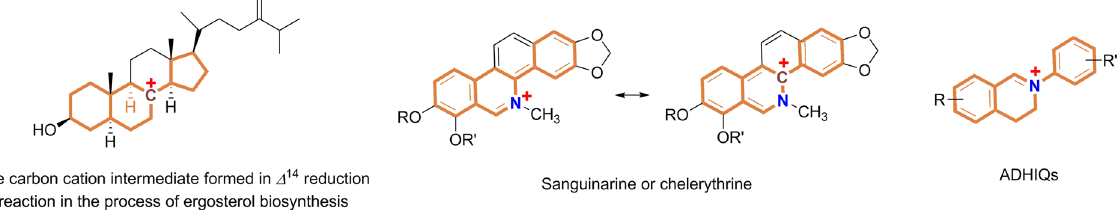
Figure 3. The structures of the carbon cation intermediate formed in the process of ergosterol biosynthesis, sanguinarine, chelerythrine and